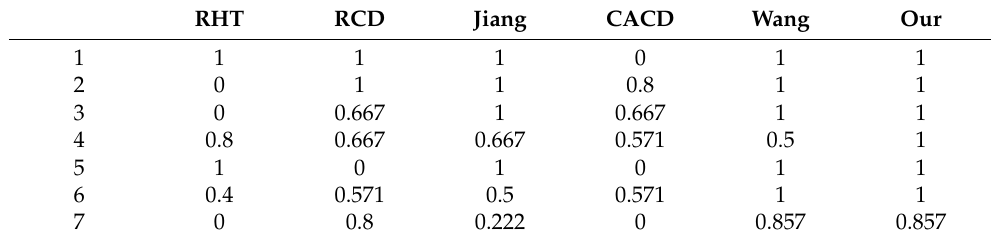
Table 4. F-measure of RHT, RCD, CACD, Jiang, Wang and our method in the dataset Geometry.